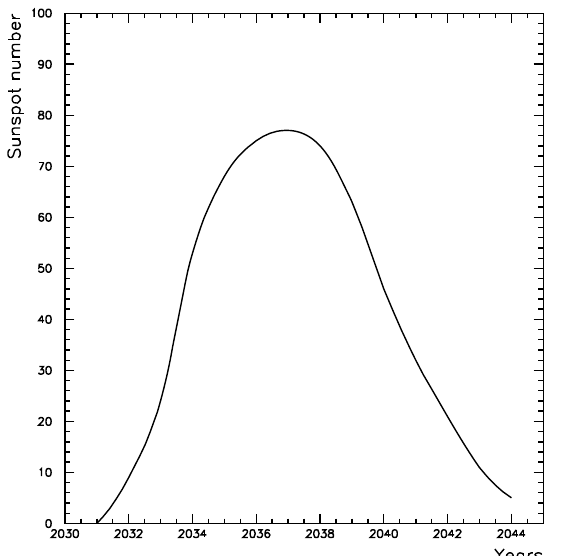
Figure 15. Sunspot number prediction for the solar cycle 26 (Singh and Bhargawa, 2019).